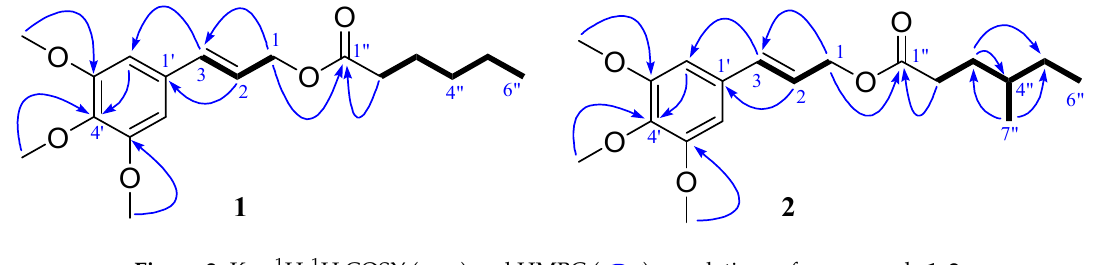
Figure 2. Key 1 H- 1 H COSY ( ) and HMBC ( ) correlations of compounds 1 – 2 . Table 1. 1 H (600 MHz) and 13 C (150 MHz) NMR spectroscopic data of 1 – 2 in CDCl 3 . ( J in Hz, δ in ppm). No.